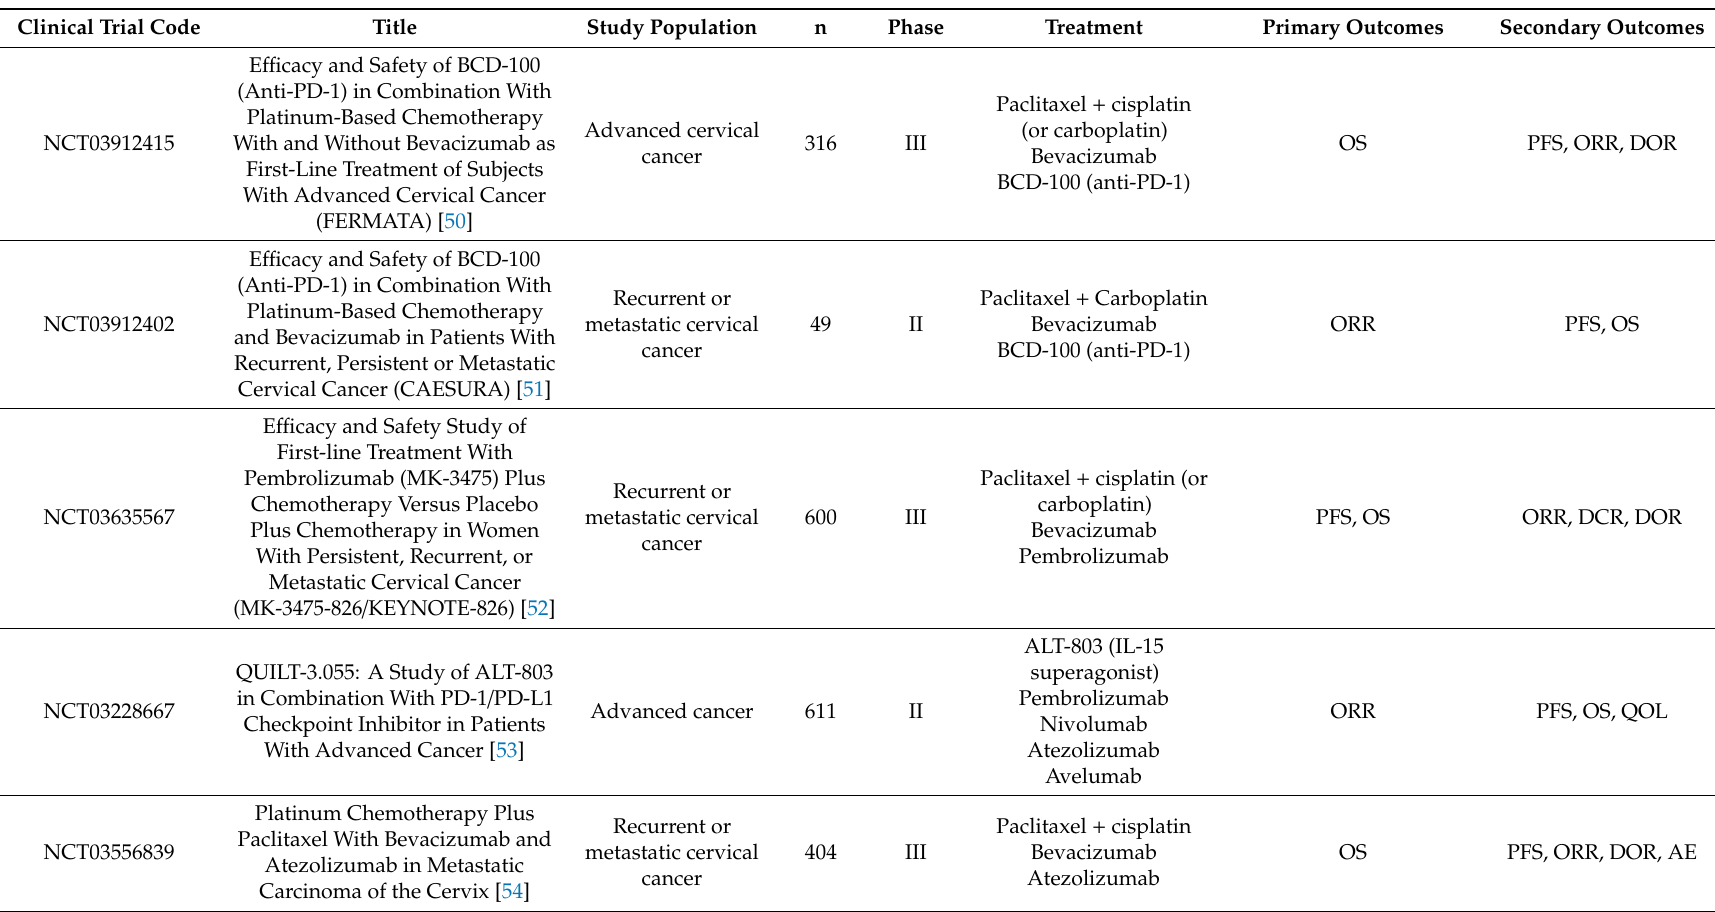
Table 4. Ongoing clinical trials of immunotherapy for cervical cancer (combination with